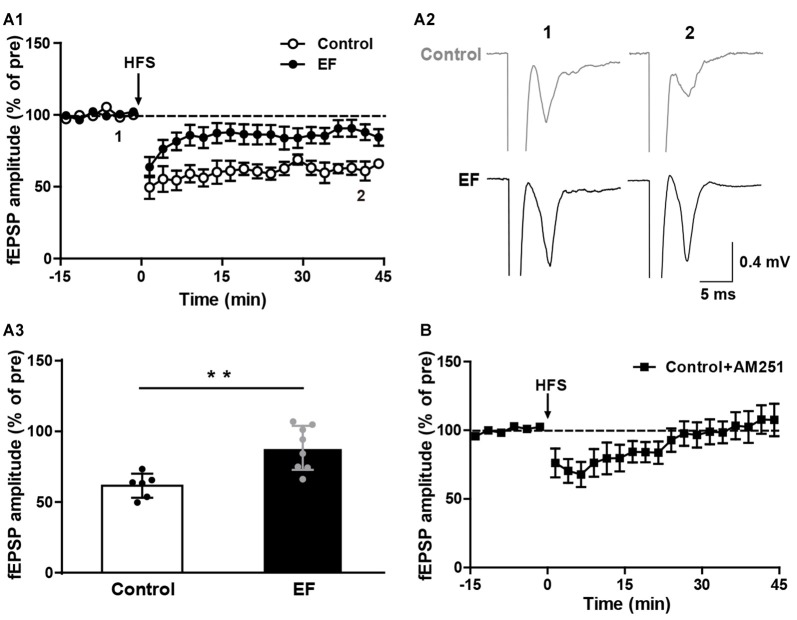
Endocannabinoid (eCB)-dependent long-term depression (LTD) was impaired in EF mice. (A1) LTD induced by HFS in Mg2+-containing ACSF was impaired in EF mice. (A2) Sample traces (average of 20 consecutive sweeps) taken at baseline (1) and the last 10 min recording (2). (A3) The average fEPSP amplitudes of the last 10 min recording (35–45 min in A1) were used for the plot. (B) Corticostriatal LTD in control mice was blocked by CB1 receptor antagonist AM251 (1 μM). All data are showed as mean ± SEM. Student’s t-test, **p < 0.01.